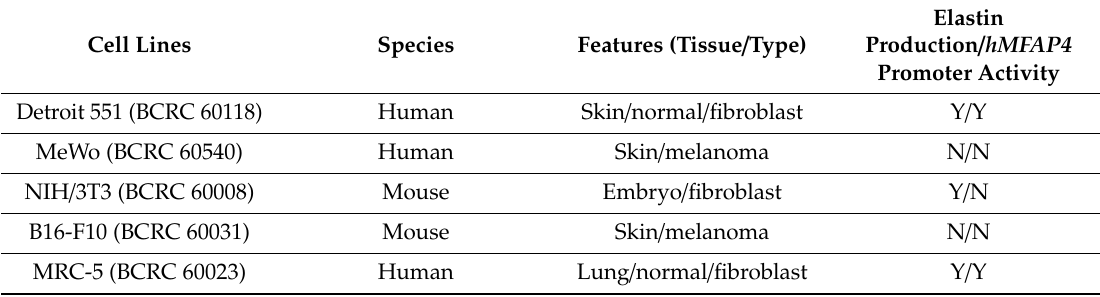
Table 2. The comparison of hMFAP4 promoter expression in the tested cell